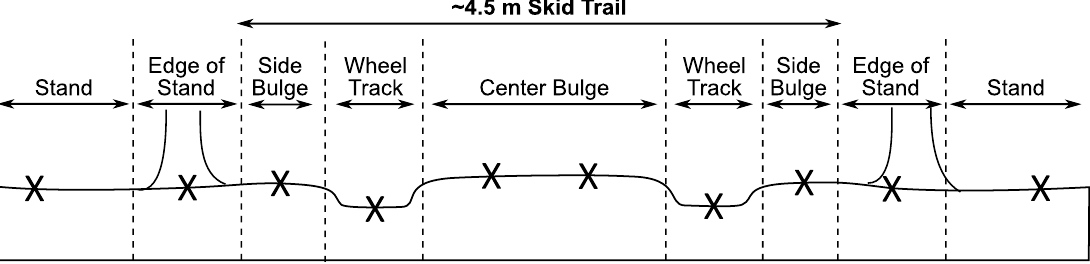
Figure 1. Profile view of the model transect. Strata are defined by relative position to wheel tracks, tree boundary, and distance to nearest skid trail. ‘X’s mark sampling